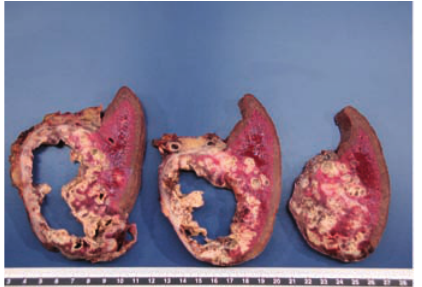
Figure 4 Macroscopic sections after splenectomy demonstrating a large central syst surrounded by multiple smaller cysts. (Photo courtesy to Dr Brigitte Christen, ADMED pathologie